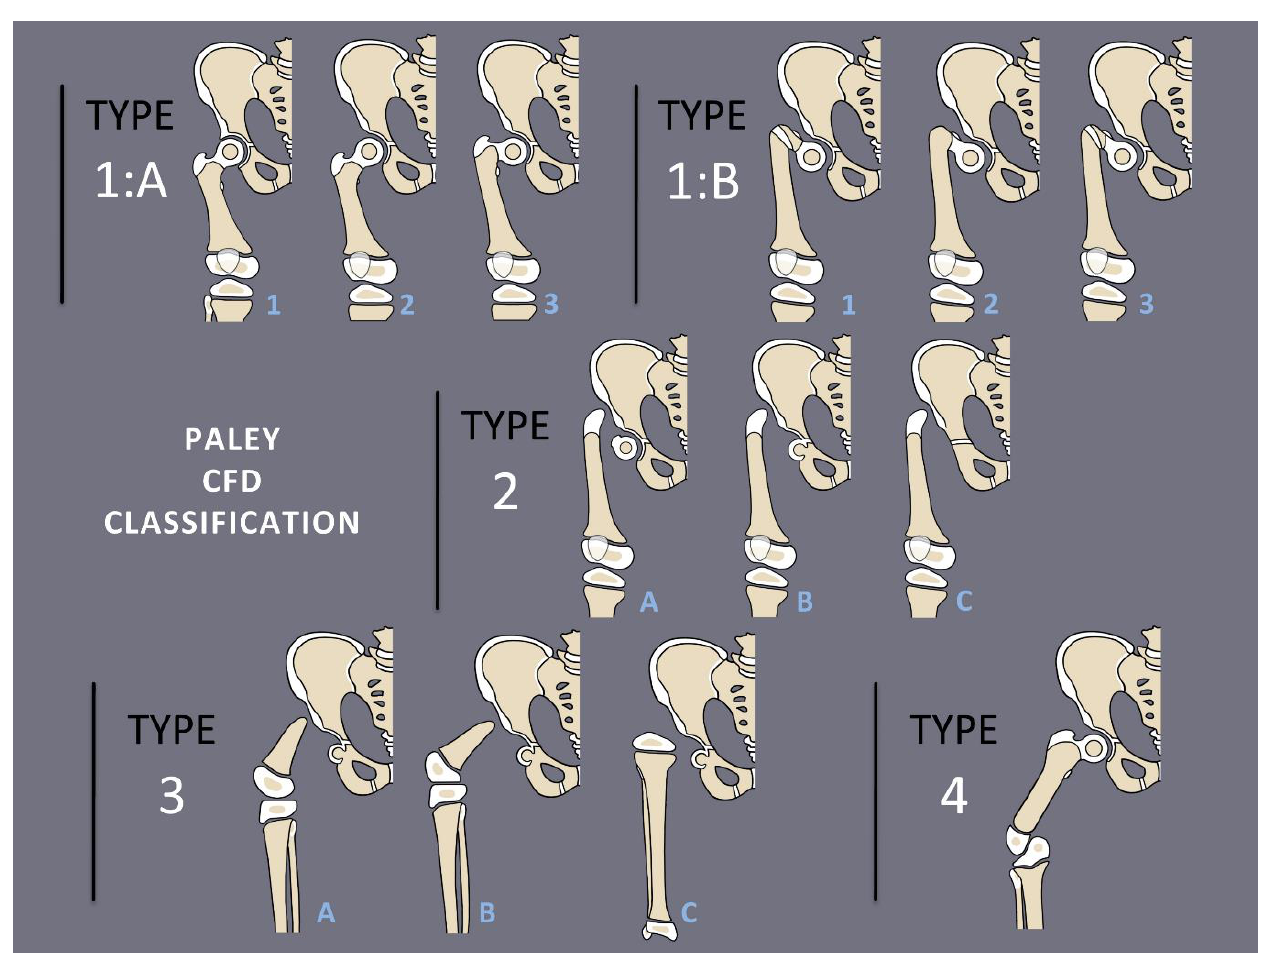
Figure 1. Paley Classification of Congenital Femoral Deficiency. Type 1A demonstrates normal ossification of the femoral neck and subtrochanteric region with normal version (1A 1 ), retroversion (1A 2 ), or varus and retroversion (1A 3 ). Type 1B demonstrates delayed ossification of the subtrochanteric region (1B 1 ), femoral neck (1B 2 ), or combined type (1B 3 ). Type 2 demonstrates an absence of the femoral neck with a mobile (2A), fused (2B), or absent (2C) femoral head. Type 3 demonstrates absence of the proximal femur with >45 degrees of knee motion (3A), <45 degrees of knee motion (3B), or complete femoral absence (3C). Type 4 demonstrates absence of the distal femur.